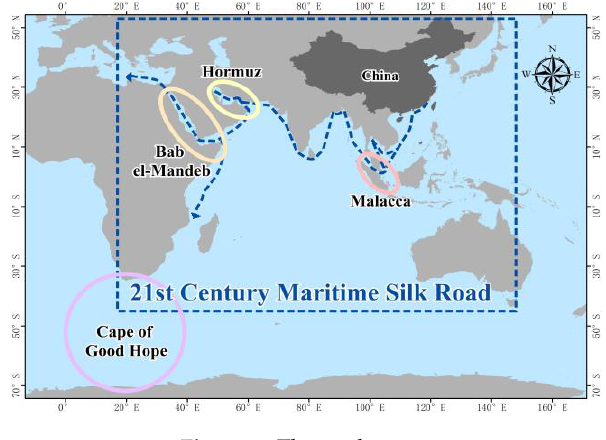
Figure 1. The study area.